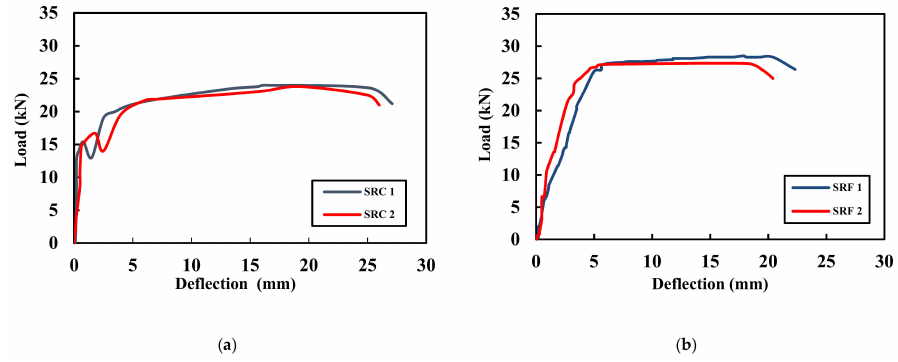
Figure 7. Load–deflection behavior of ( a ) SRC and ( b ) SRF.